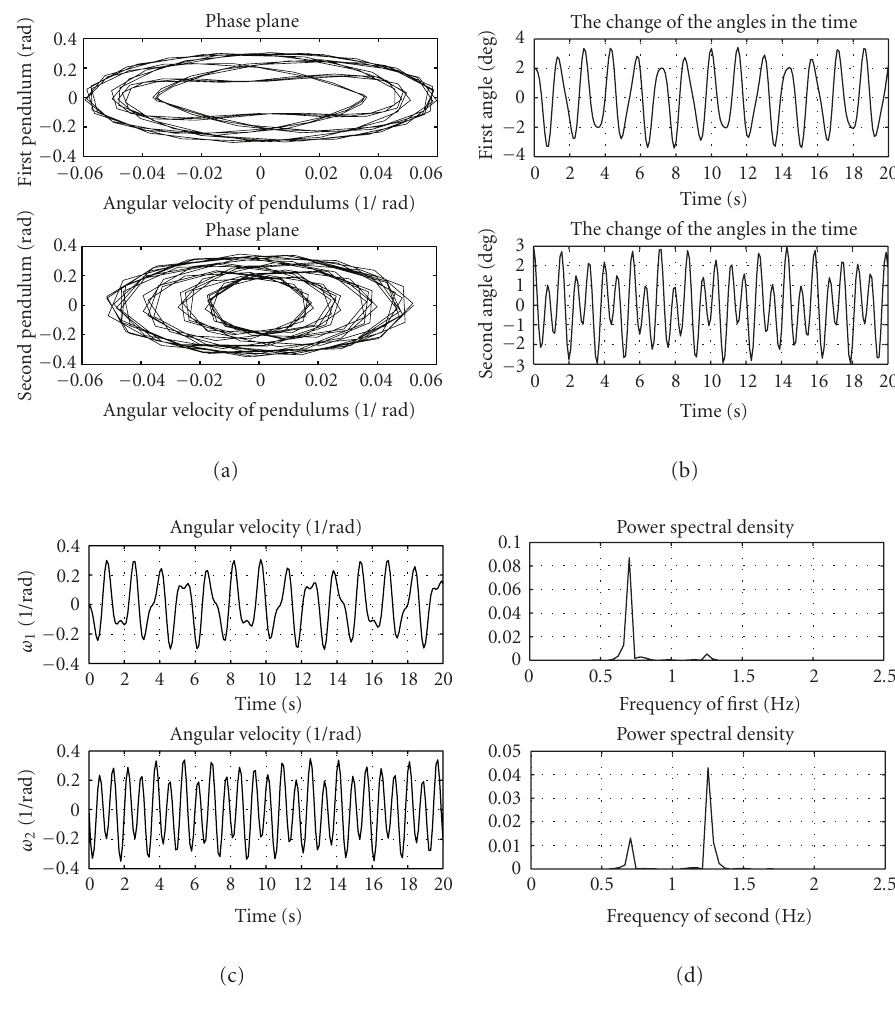
Figure 2.1. (a) “Phase portraits” for the two pendulums; (b) swinging angles ϕ 1 ( t ) and ϕ 2 ( t ); (c) swinging speeds ˙ ϕ 1 ( t ) and ˙ ϕ 2 ( t ); (d) spectrum distribution for the two